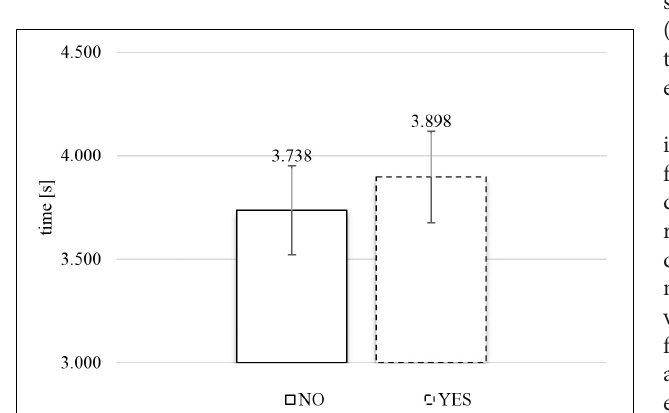
FIGURE 8 | Average exposure time of rejected (NO) and included (YES) naturalistic food images in the time-controlled exclusive evaluation ( N = 75). Error bars reflect the 95% confidence interval around the mean.